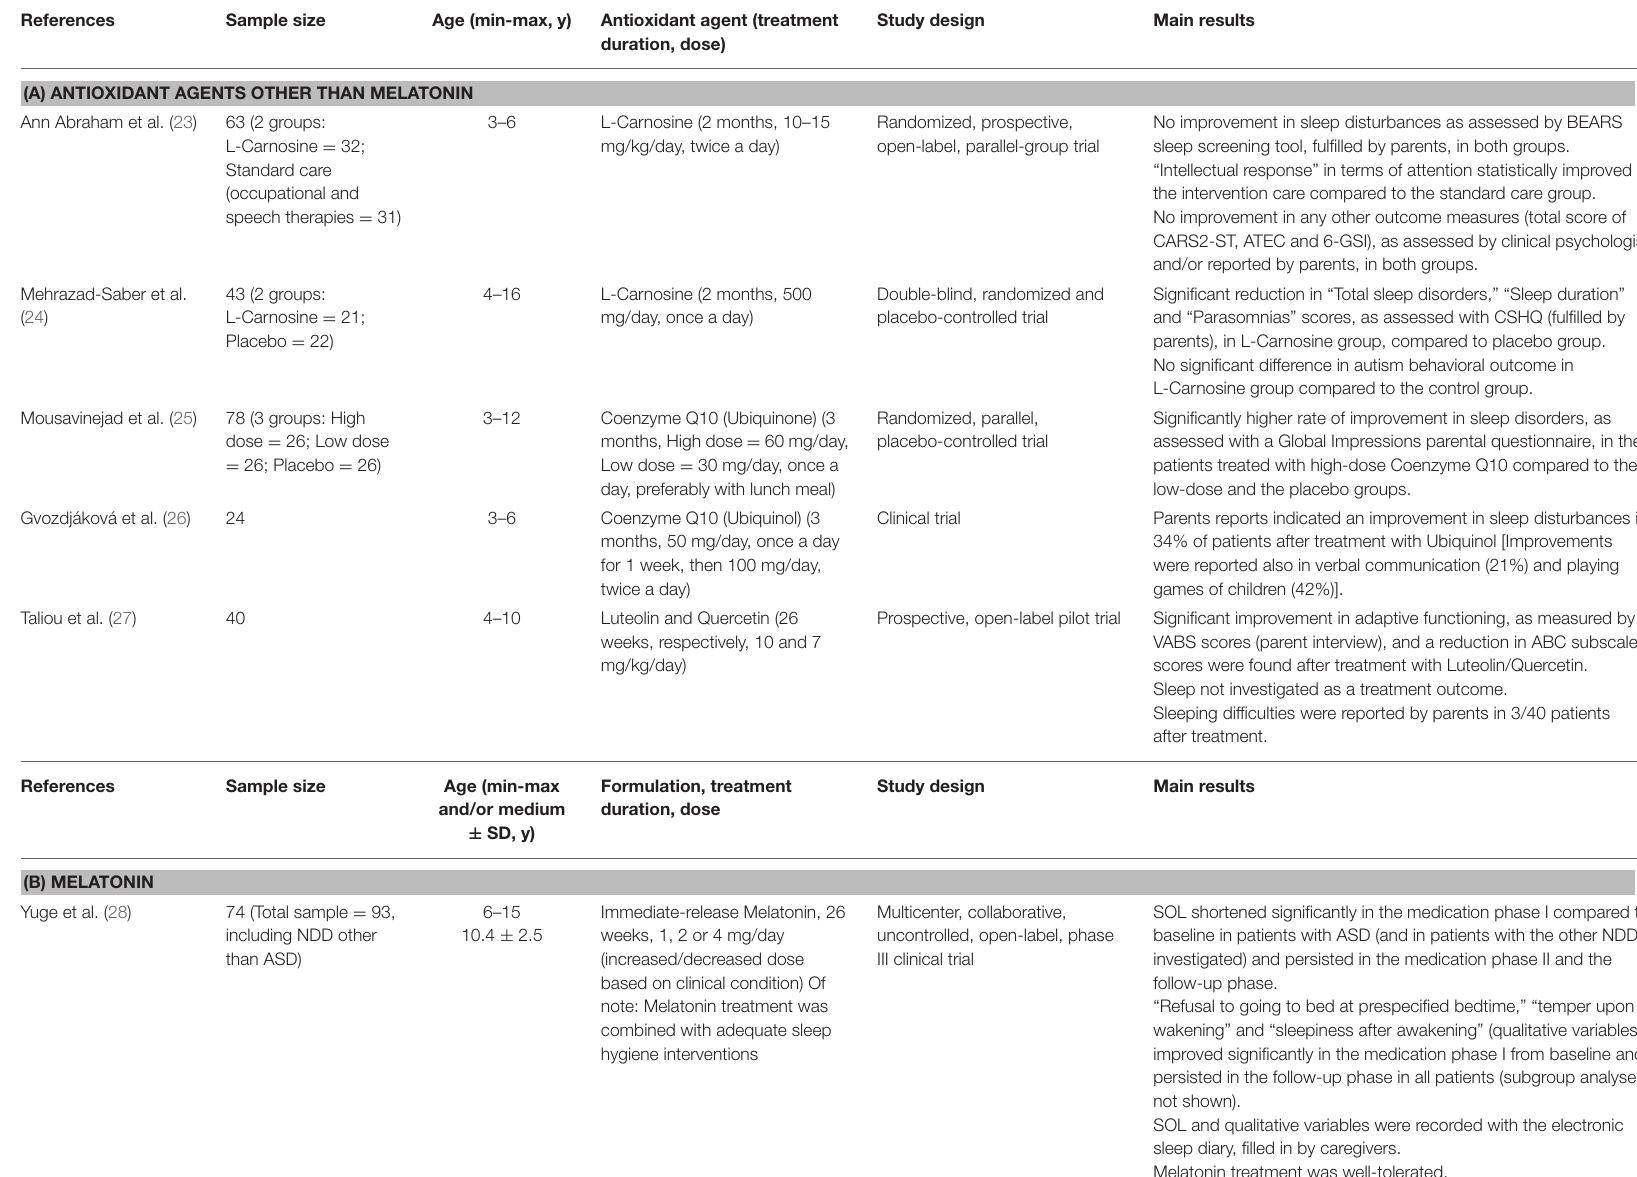
TABLE 1 | Articles investigating the effect of antioxidant agent supplementation on sleep disturbances in children with ASD, included in the final